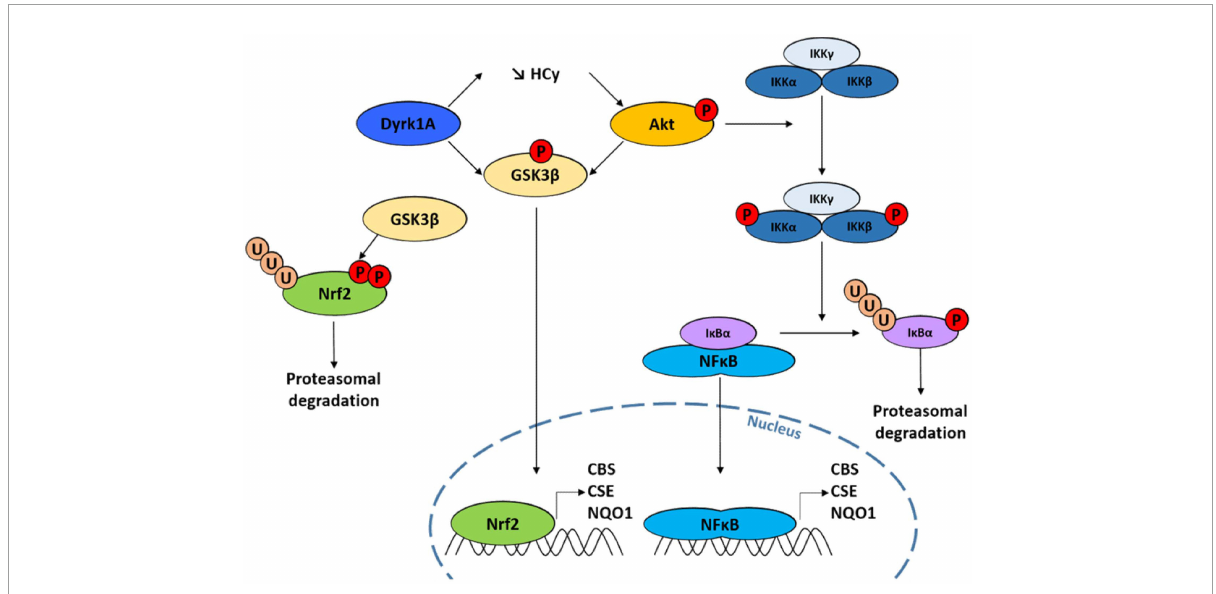
FIGURE5 Scheme illustrating the genetic connection between Dual specificity tyrosine phosphorylation Regulated Kinase 1A (DYRK1A), GSK3 β and Cystathionine beta synthase (CBS) through the Akt and NF- κ B pathways.